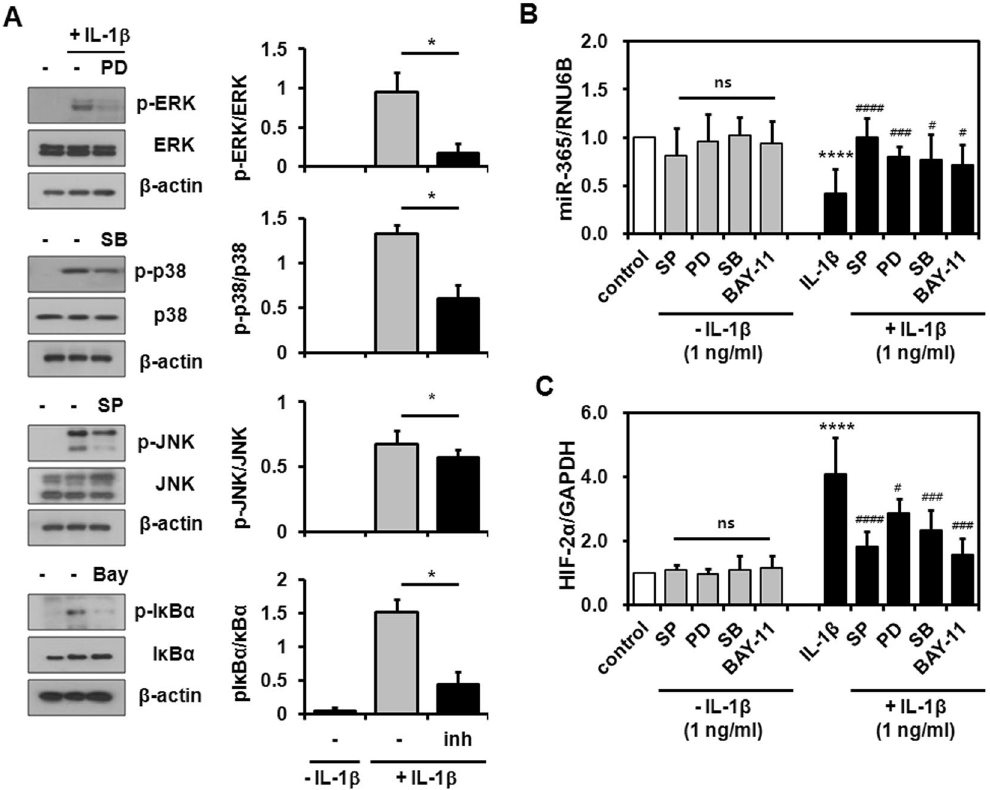
Figure 3. Modulation of miR-365 and HIF-2 α expression by IL-1 β signaling pathways. Human OA chondrocytes were incubated for 2 h with MAPK and I κ B α inhibitors, including SP600125 (SP, 10 µ M), PD98059 (PD, 10 µ M), SB203580 (SB, 1 µ M), and Bay 11-7082 (Bay, 5 µ M), and stimulated with IL-1 β (1 ng/ mL) for 6 h. ( A ) Inactivation of MAPK and I κ B α by MAPK and I κ B α inhibitors at each concentration used in this experiments. ( B , C ) The levels of ( B ) miR-365 and ( C ) HIF-2 α were measured. RNU6B and GAPDH were used as endogenous controls. Data are expressed as the mean ± SD of duplicate data from more than four independent experiments. ns, not significant, **** P < 0.001 vs. unstimulated control; # P < 0.05, ### P < 0.005, #### P < 0.001 vs. IL-1 β -stimulated